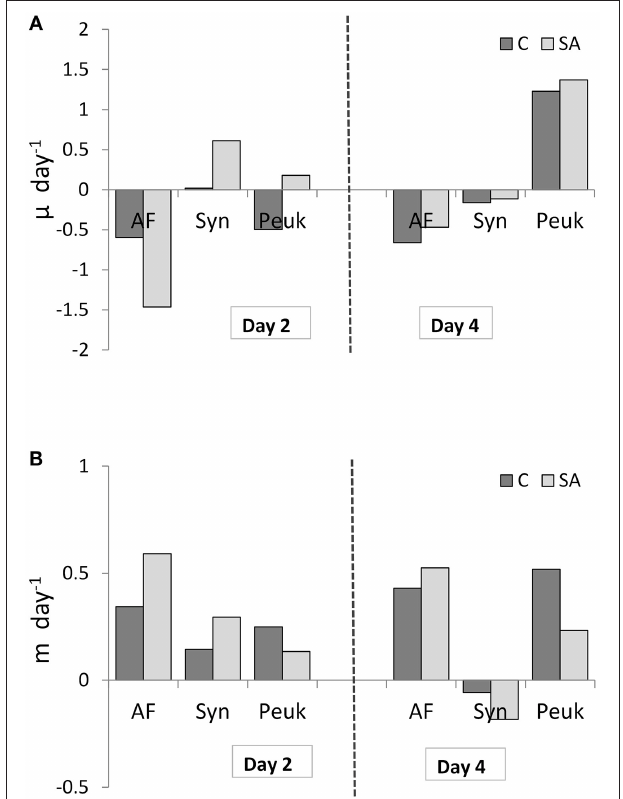
FIGURE 10 | (A) Net growth rate ( µ ) and (B) grazing mortality (m) of autotrophic flagellates (AF), Synechococcus (Syn) and pico-eukaryotes (Peuk) on Days 2 and 4 as measured by means of dilution experiments in Cnt = Control mesocosms (no addition) and SA = single addition mesocosms (where dust was added once, on the first day of the